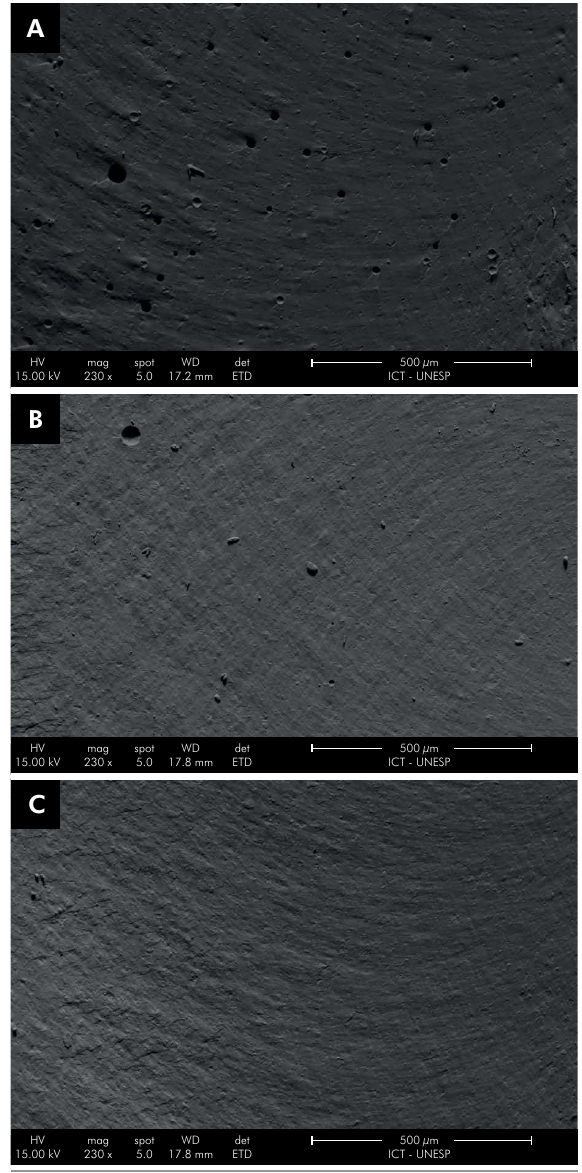
Figure 2. Representative SEM images of fracture surfaces from A) C1; B) C2, and C) C3 groups. Several pores are seen in